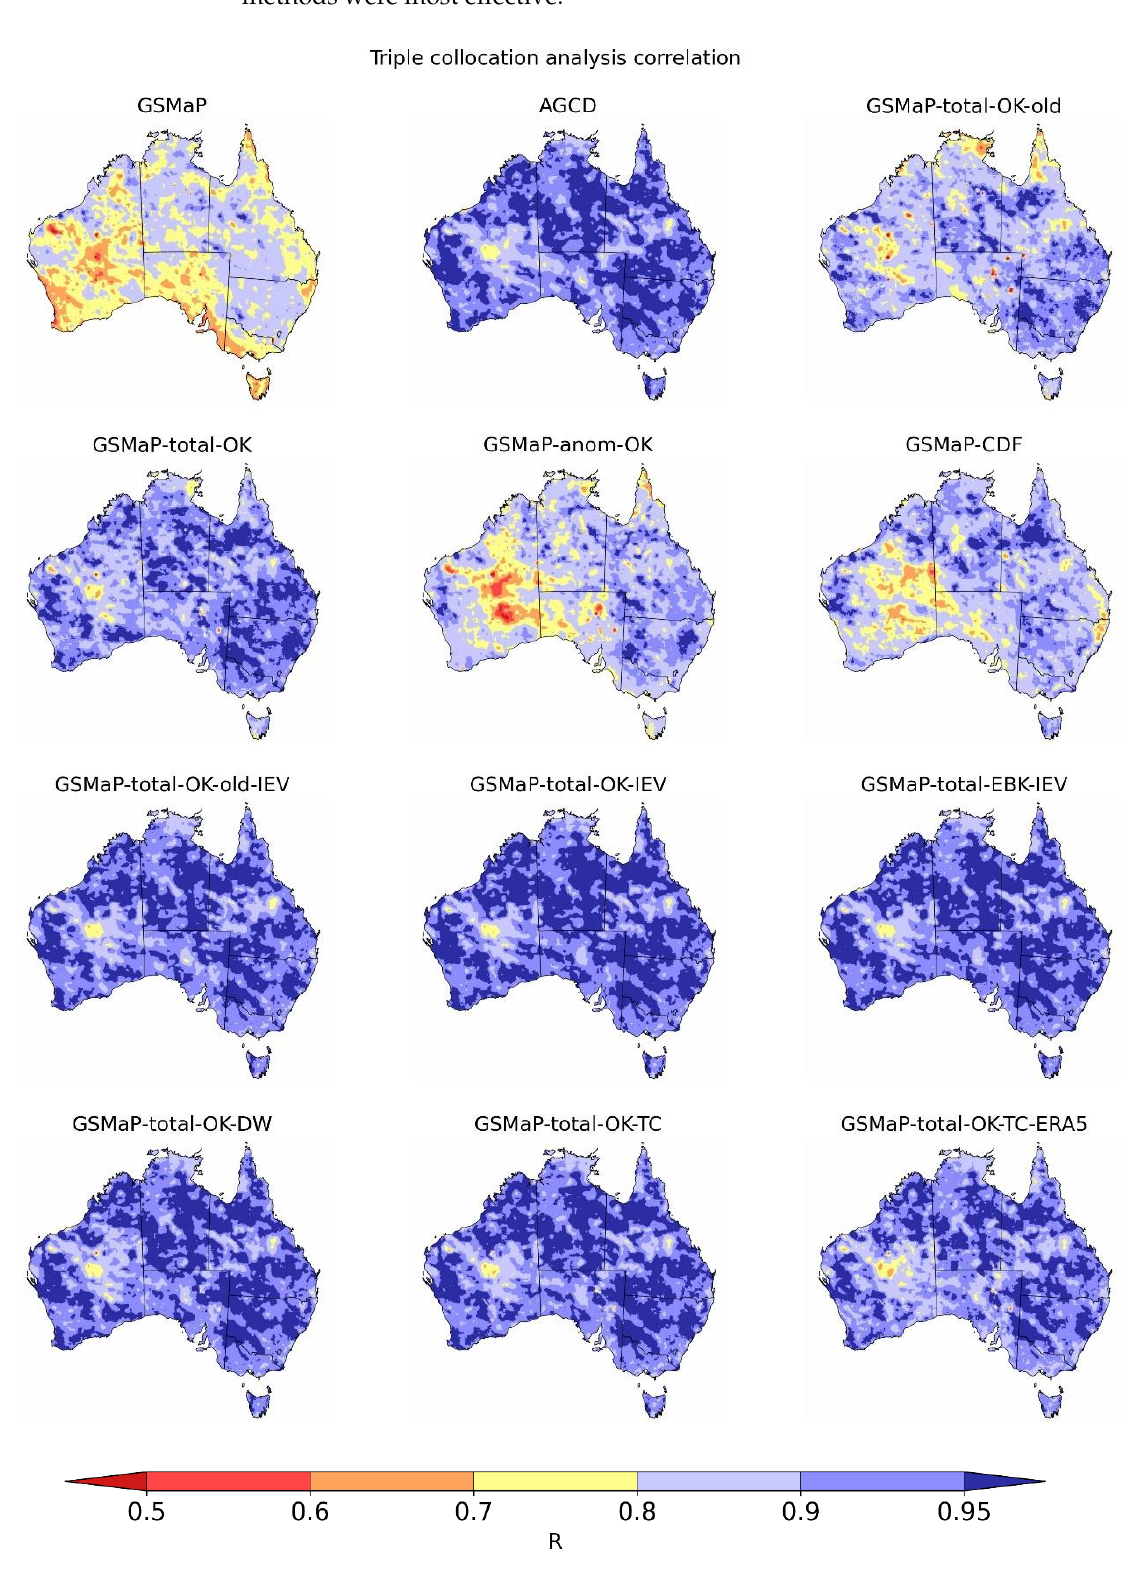
Figure 5. Correlations obtained using triple collocation analysis for corrected and blended datasets.